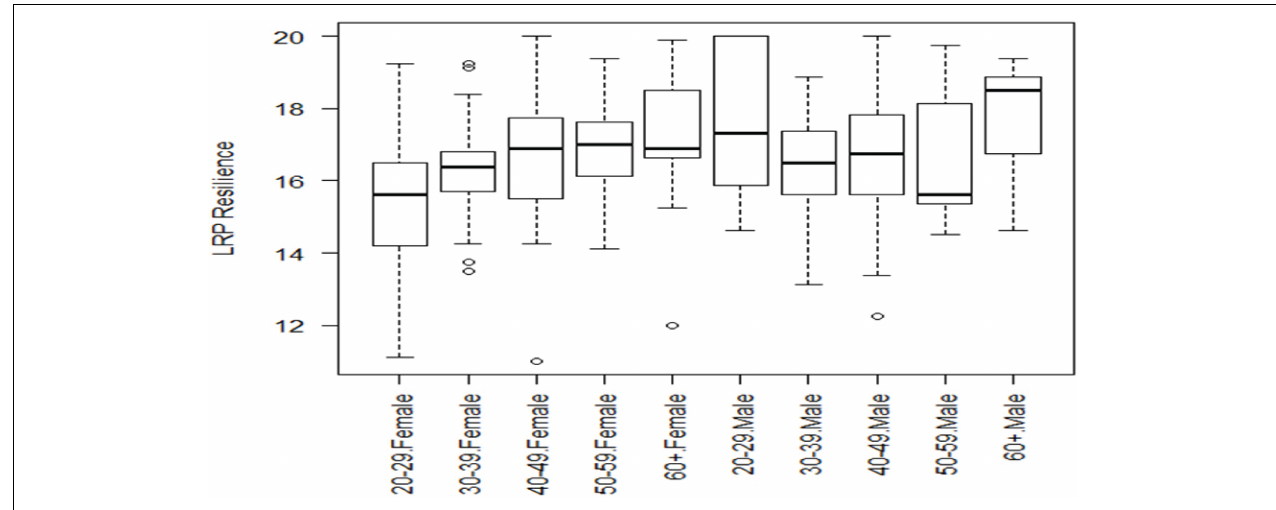
FIGURE 3 | LRP-R resilience by gender and